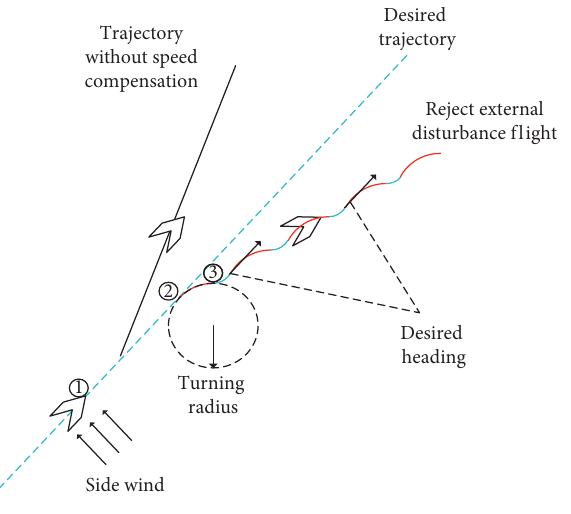
Figure 2: The properties of “reject external disturbance” flight mode.